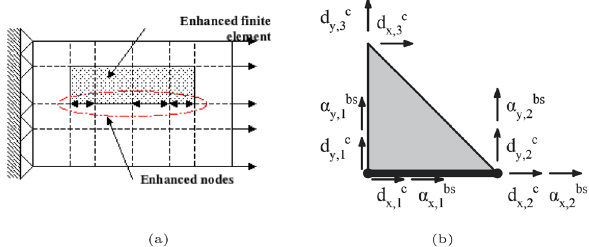
Fig. 20 RC composite finite element model: a ED-FEM for concrete cracks (element-wise) representation and X-FEM for bond-slip (rein- forcement bar) representation; b Combined representation and corresponding nodal displacements: d c concrete, 𝛼 bs bond-slip, d s = d c + 𝛼 bs steel reinforcement